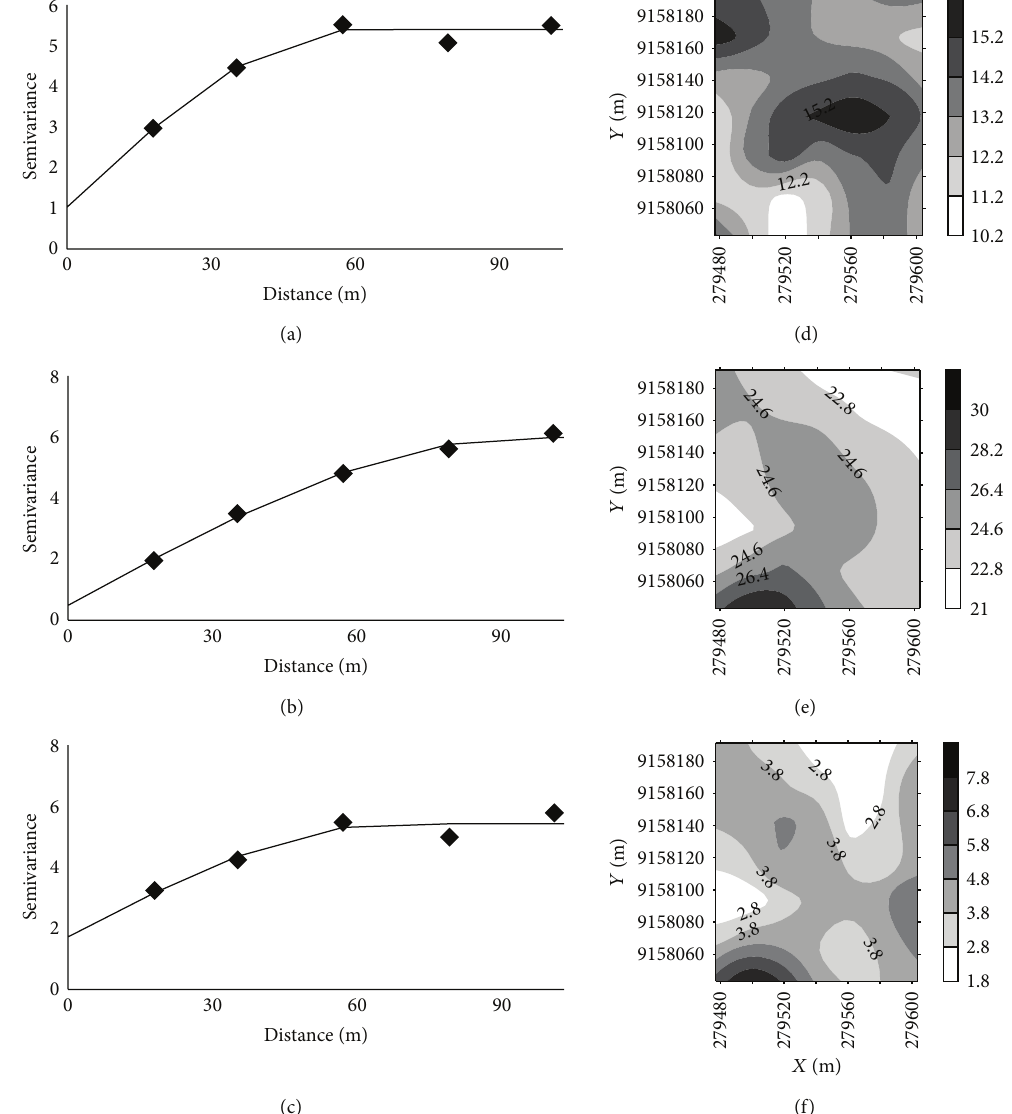
Figure 5: Semivariogram parameters of soil moisture (a), LL (b), and PI (c) and contour maps of soil moisture (d), LL (e), and PI (f).